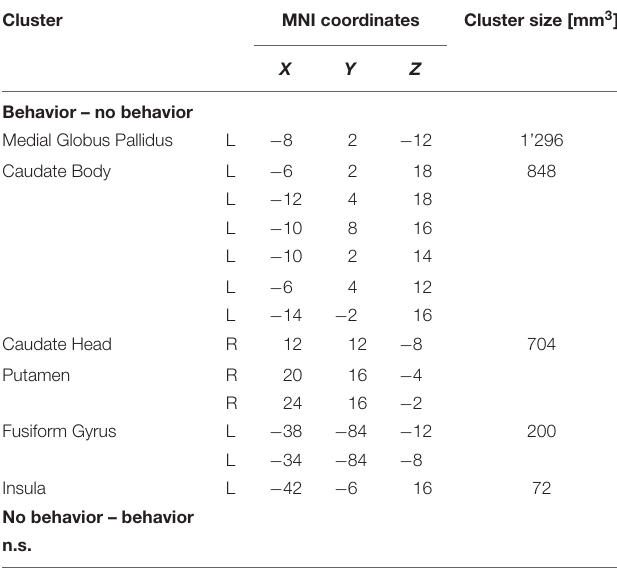
TABLE 4 | Details of the clusters revealed by subtraction